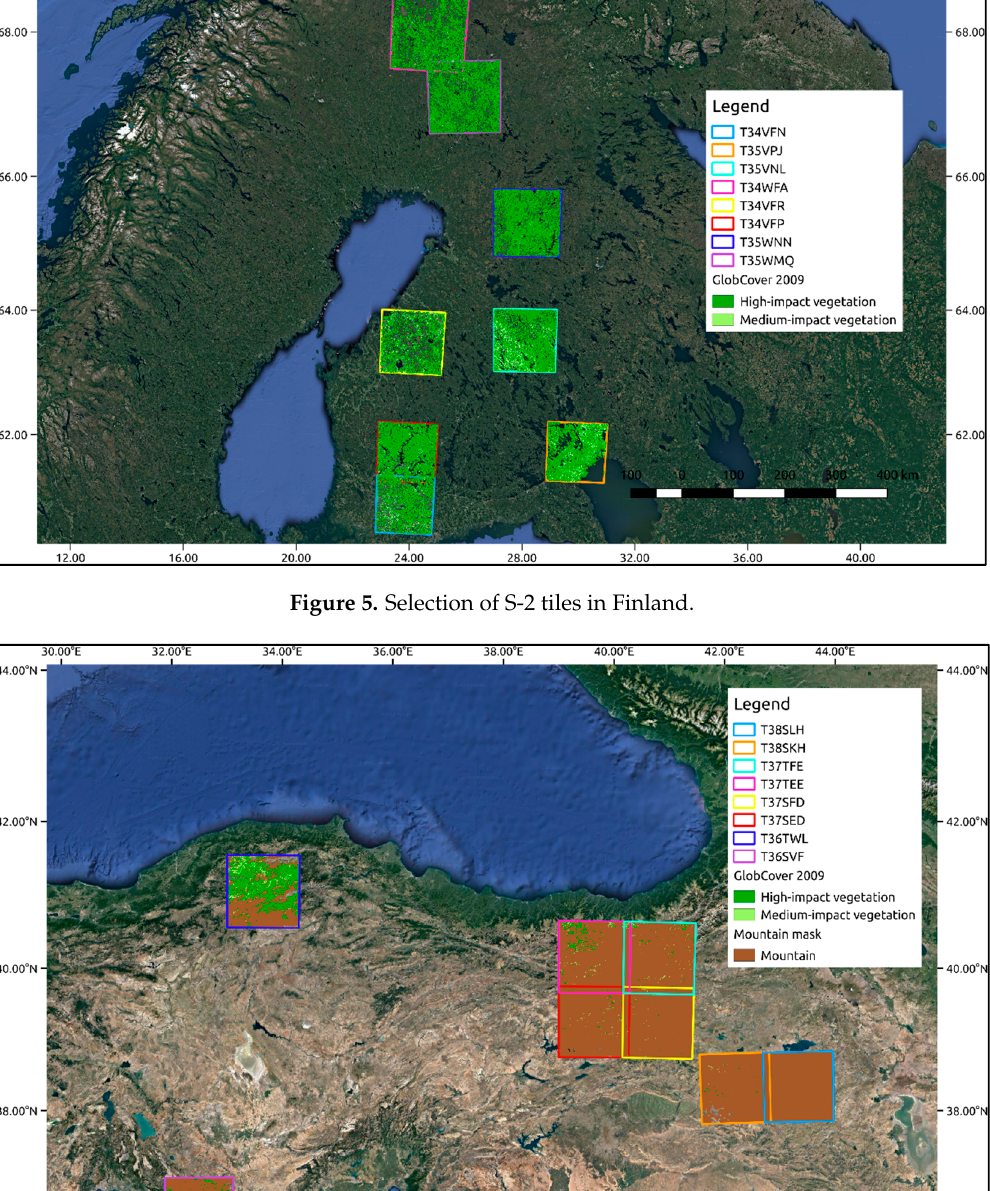
Figure 4. Selection of S-2 tiles over Italian Alps.